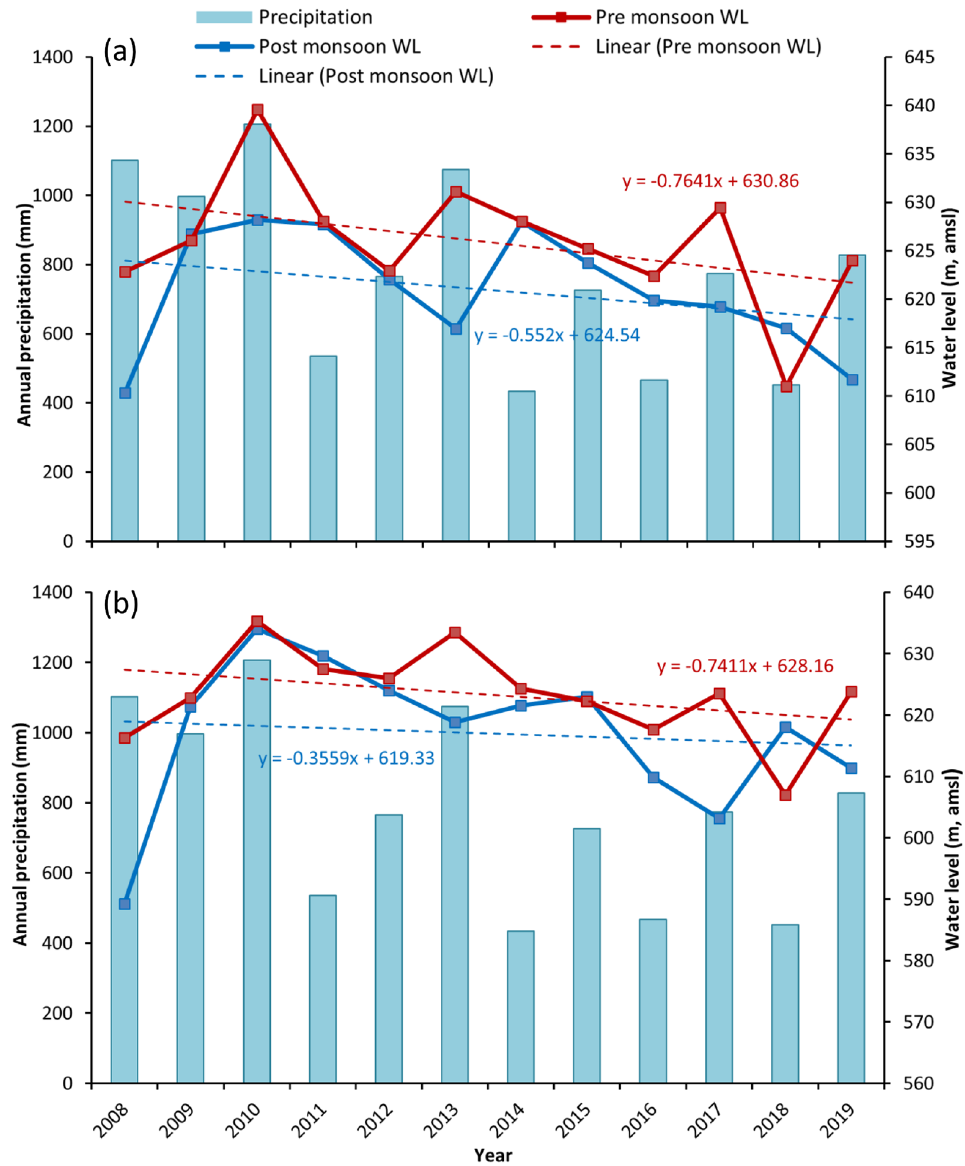
Figure 6. Graph showing the temporal variation of water level fluctuation (meter, above mean sea level) in the areas of ( a ) low recharge zone and ( b ) high recharge zone.